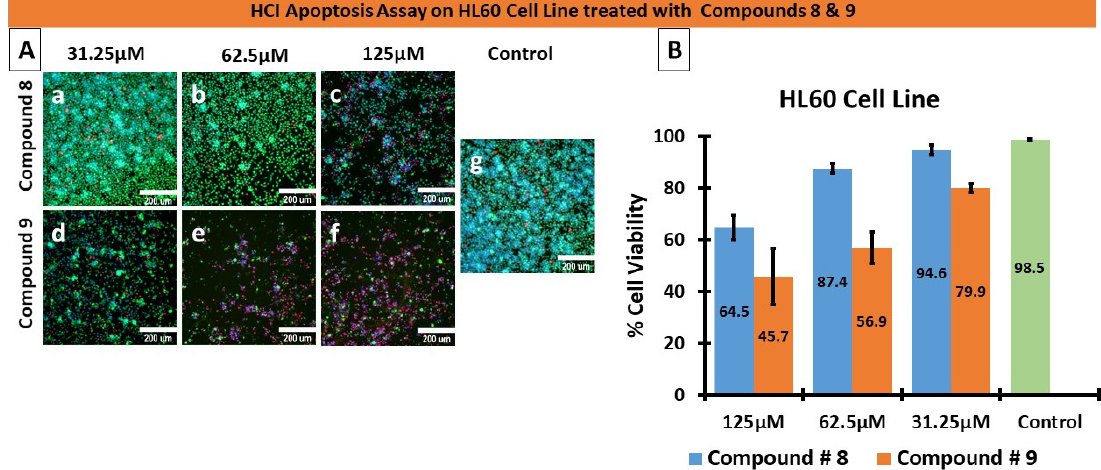
Figure 5. HCI-based apoptosis assay. ( A ) HL60 cells were treated with three concentrations (31.25 µ M, 62.5 µ M, and 125 µ M) of compounds # 8 ( a – c ), # 9 ( d – f ), and PBS for the negative control ( g ) for 48 h. The nucleus (blue) was stained with HOECHST 33342, the cytoplasm (Green) was stained with Calcein AM, and dead cells (Red) were stained with Propidium Iodide (PI). Compound # 9 was more potent than compound 8, indicated by the presence of dead cells (red) and diminished Calcein AM (Green) staining. ( B ) HCI Cell Health Digital Analysis MetaXpress software generated the graph quantifying the cell viability, seen in B, as a percentage of HL60 cells treated with the compounds. At low concentrations of 31.25 µ M, compound 9 displayed approximately 20% cytotoxic efficacy and approximately 54% cytotoxicity at 62.5 µ M